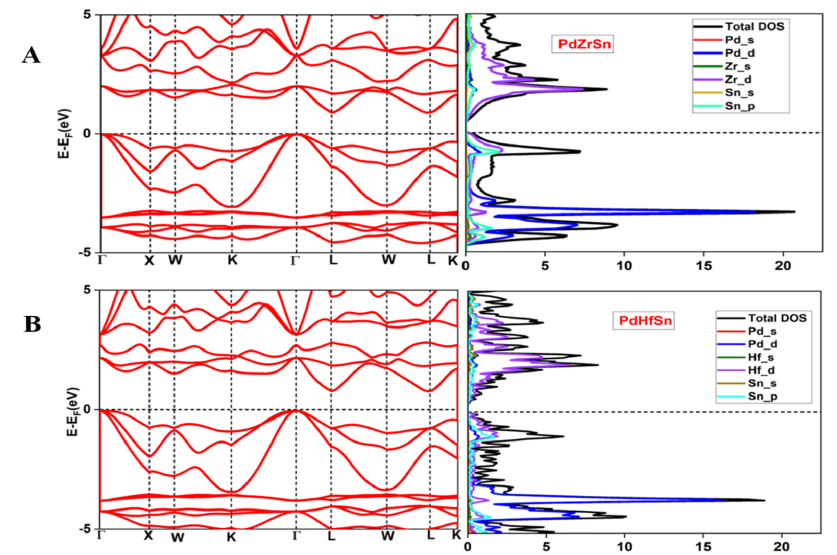
Figure 3. Electronic band structure and DOS for HH materials: ( A ) PdZrSn; ( B ) PdHfSn. Under the parabolic approximation, the effective mass for both types of charge carri-